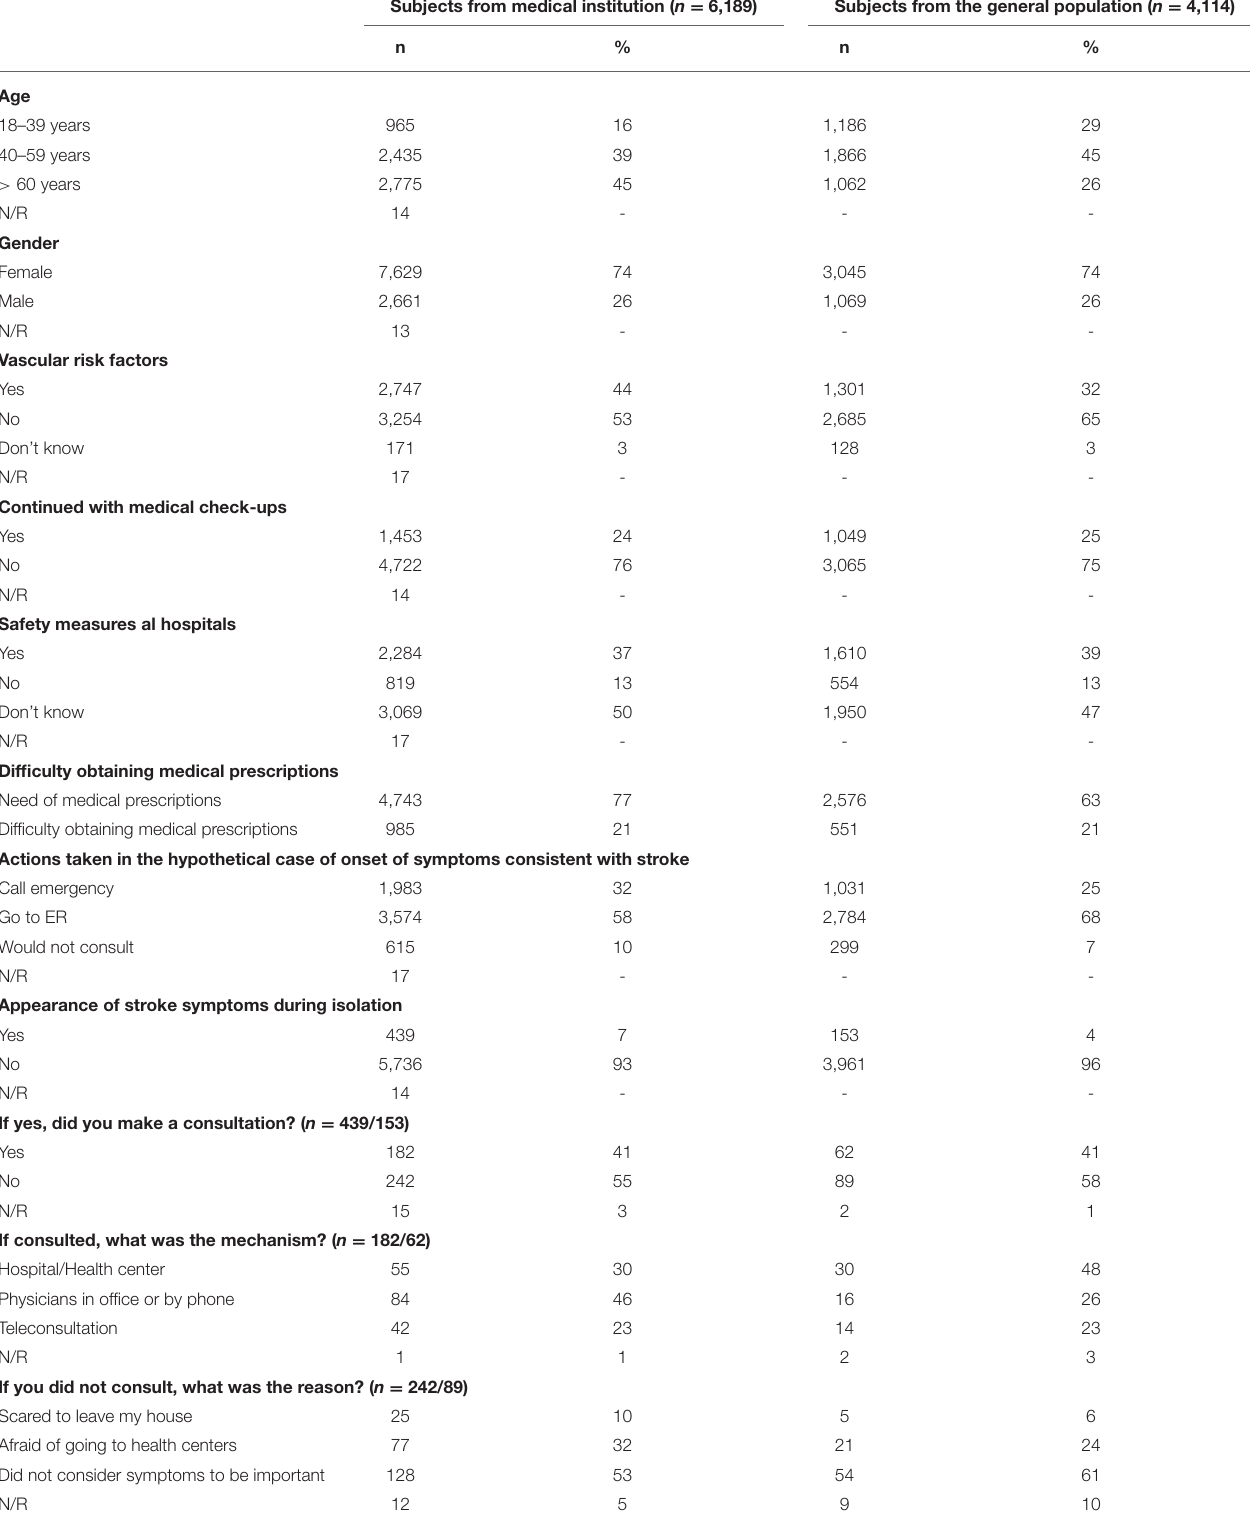
TABLE 3 | Demographic data, vascular risk factors and behavior of the two cohorts included in the study. Subjects from medical institution ( n = 6,189) Subjects from the general population ( n =